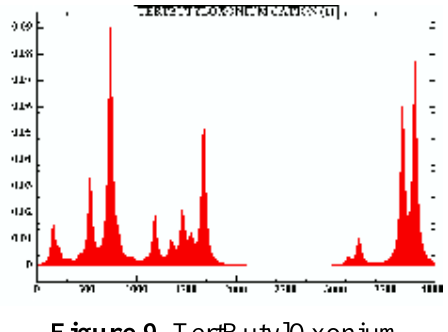
Figure 8. IsoButylOxonium Figure 9. TertButylOxonium. (Y intensity au / X frequency cm -1